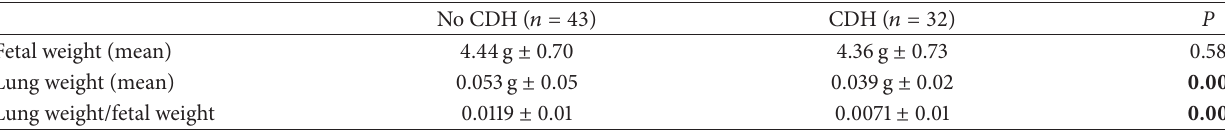
Table 2: Group exposed to nitrofen (75 fetuses). Comparison of mean weights according to presence or not of congenital diaphragmatic hernia (CDH).